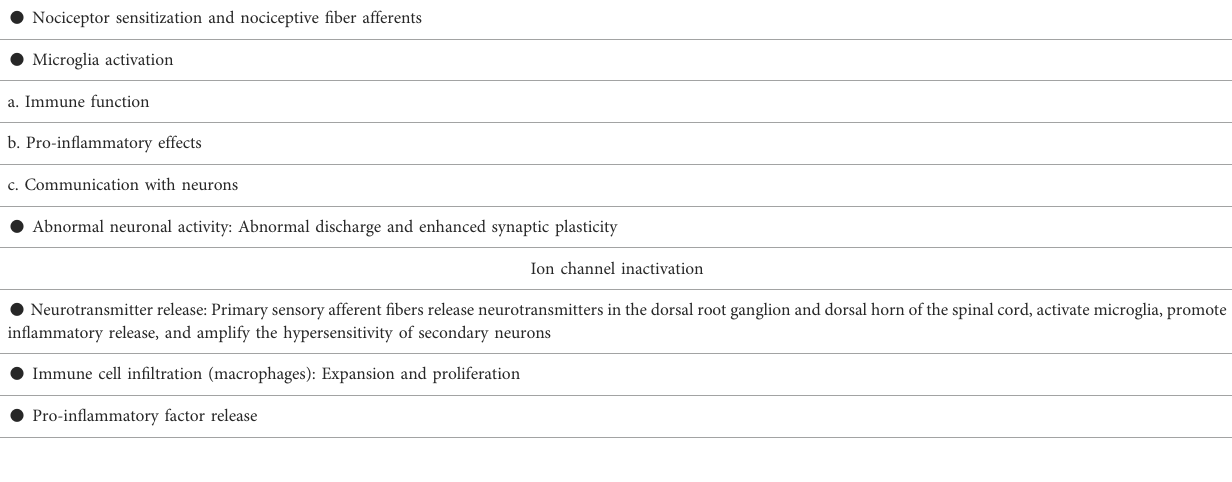
TABLE 2 Potential mechanisms of neuropathic pain (NPP). C Nociceptor sensitization and nociceptive fi ber